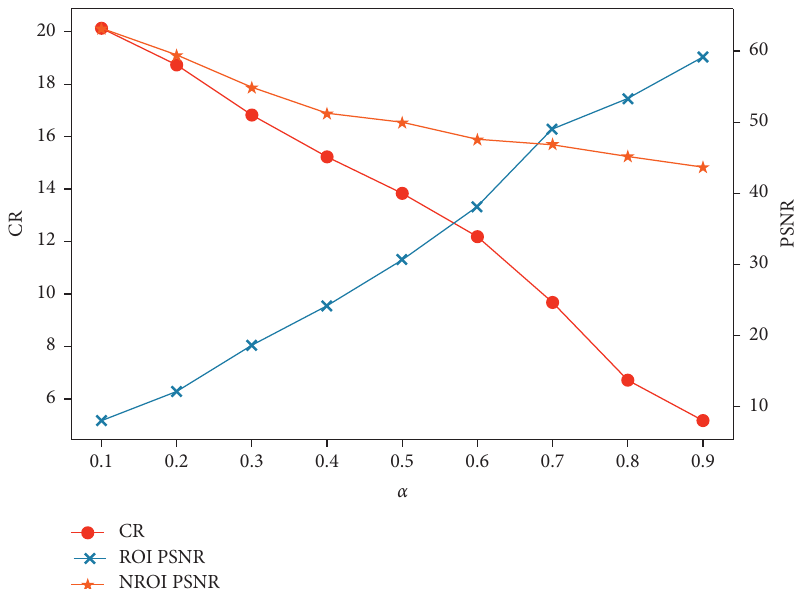
Figure 4: PSNR values of the ROI and NROI versus different values of ∝ . Table 2: Summary of the performance measures for the proposed compression method at ∝ � 0 . 7 . This study ( ∝ � 0 . Category